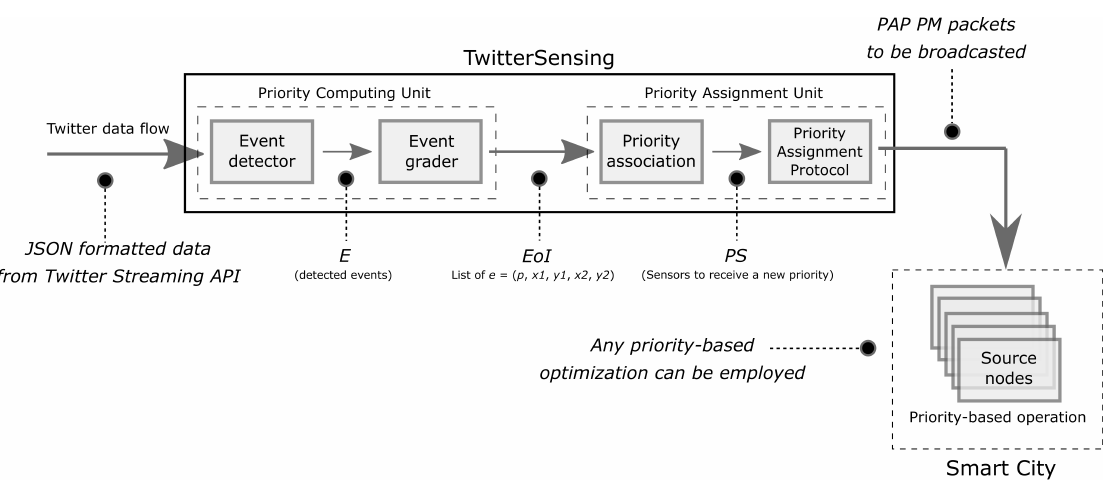
Figure 3. Schematic operation of the proposed